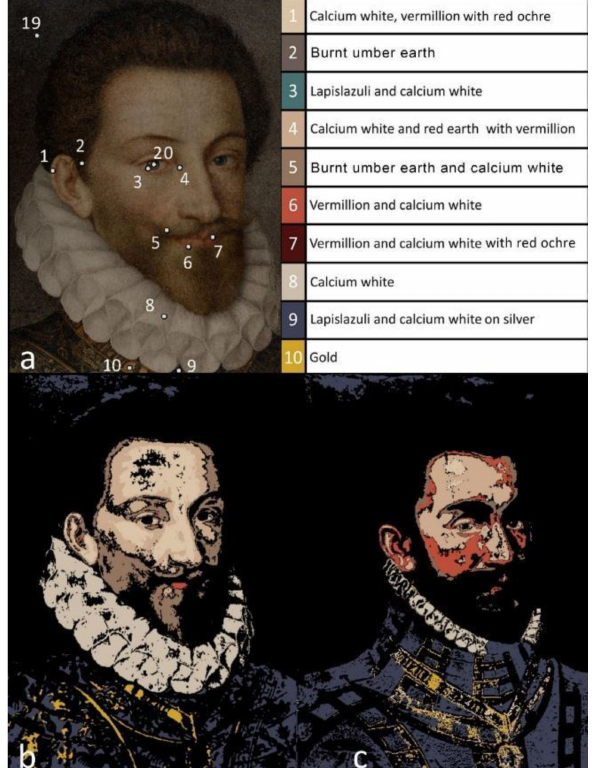
Figure 7. Portrait of Carlo Emanuele I: ( a ) map of analyzed point using FORS and XRF spectroscopy, ( b ) result of the SAM algorithm to map similar pigments and pigments mixtures represented in pseudo-colors, ( c ) SAM mapping of Emanuele Filiberto for materials